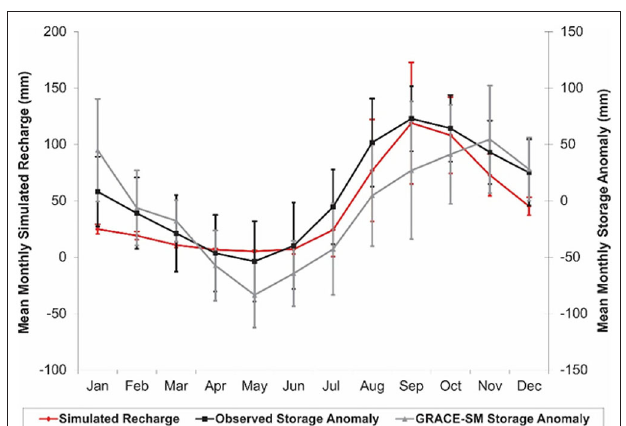
FIGURE 11 | Mean monthly simulated recharge for the average of all four unsaturated zone groups at three depth intervals (12 simulations) (left y-axis), with the mean monthly storage anomalies for the entire region compiled from all observation wells and interpreted groundwater storage GRACE – SM (right y-axis). Error bars represent the standard deviation in each